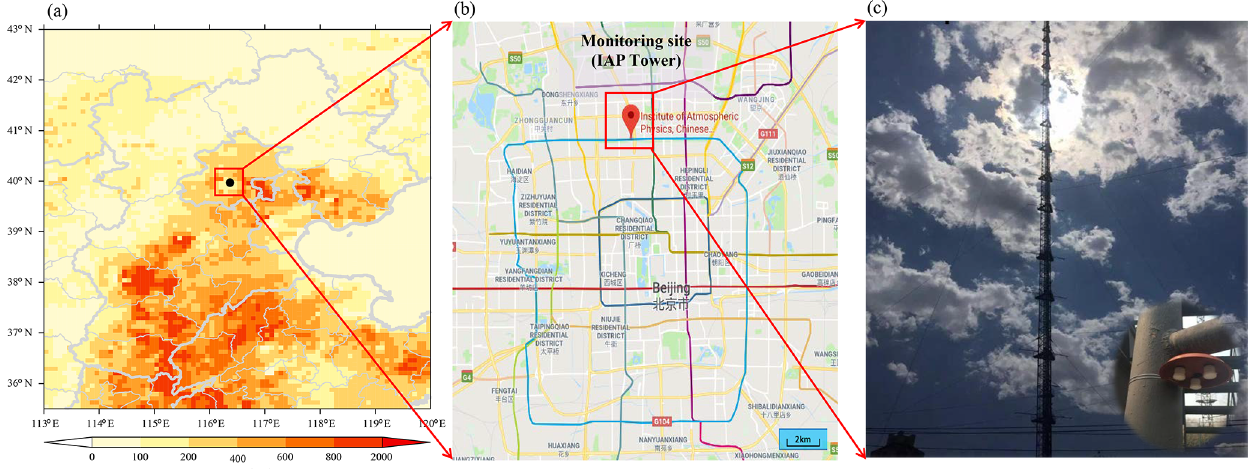
Figure 1. (a) Modeled NH 3 emissions distribution (0.1 ◦ , ∼ 10km) over the North China Plain in 2015 including the location of the monitor- ing site shown as a black dot. NH 3 emission estimates are from the inventory of Zhang et al. (2018) at a 0.1 ◦ horizontal resolution. (b) Map of Beijing showing the location of the monitoring tower. (c) The 325m meteorological tower and ALPHA passive